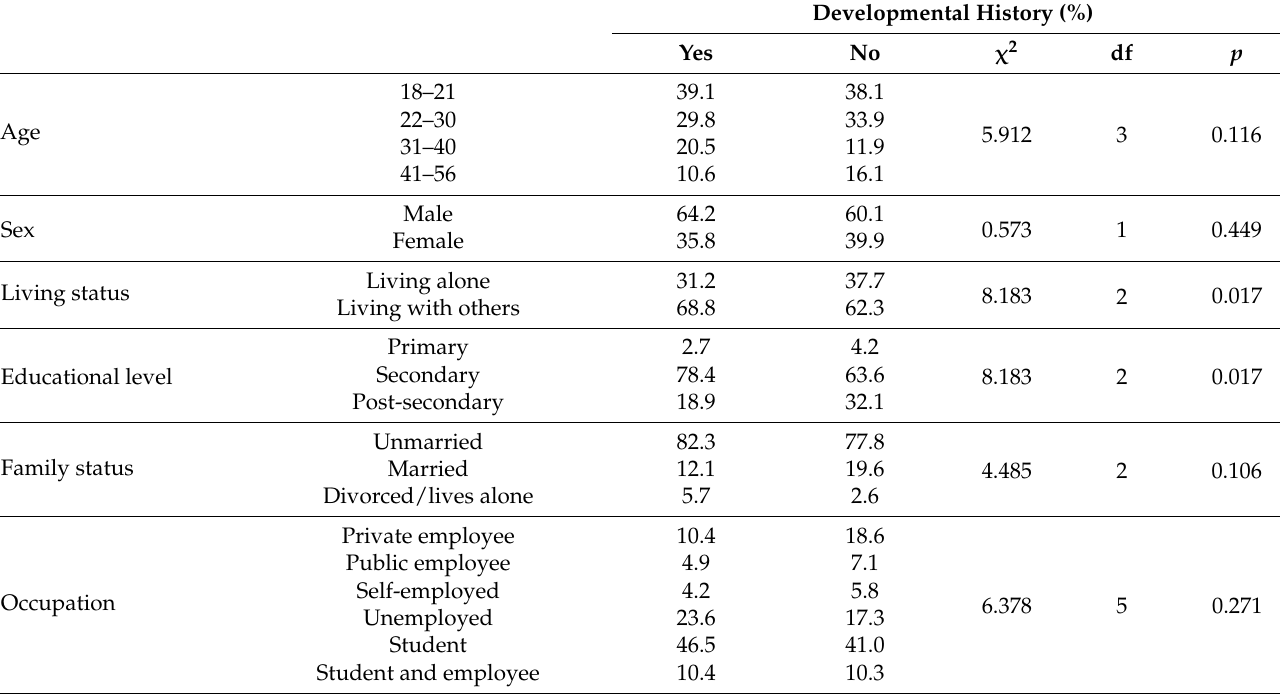
Table A8. Relationship of the Developmental history of the assessed adults with the other